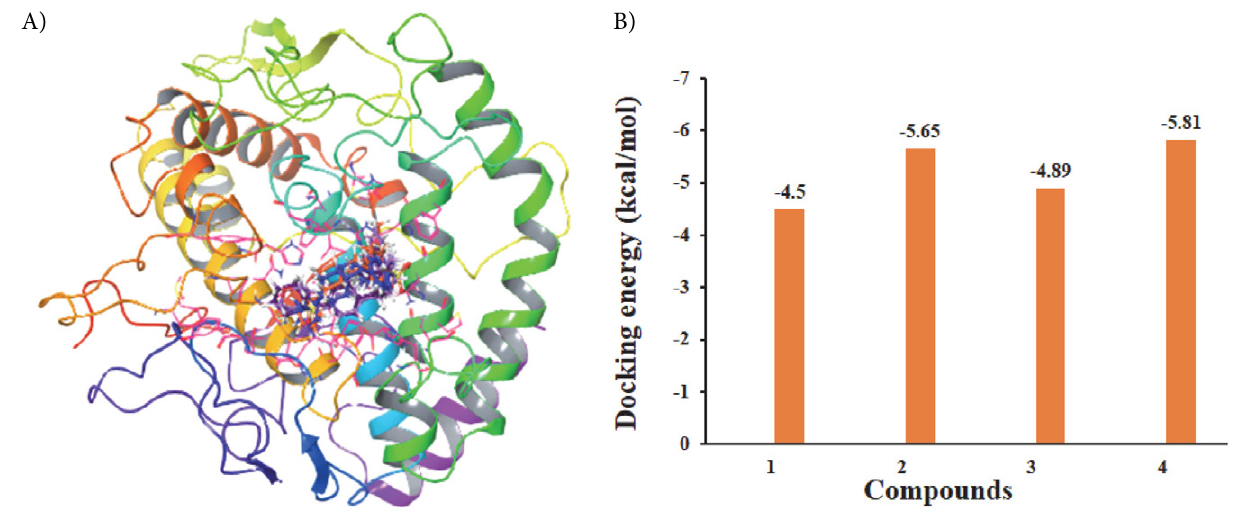
Figure 6. All the tyrosinase docking complexes (A) and their docking energy values (B).